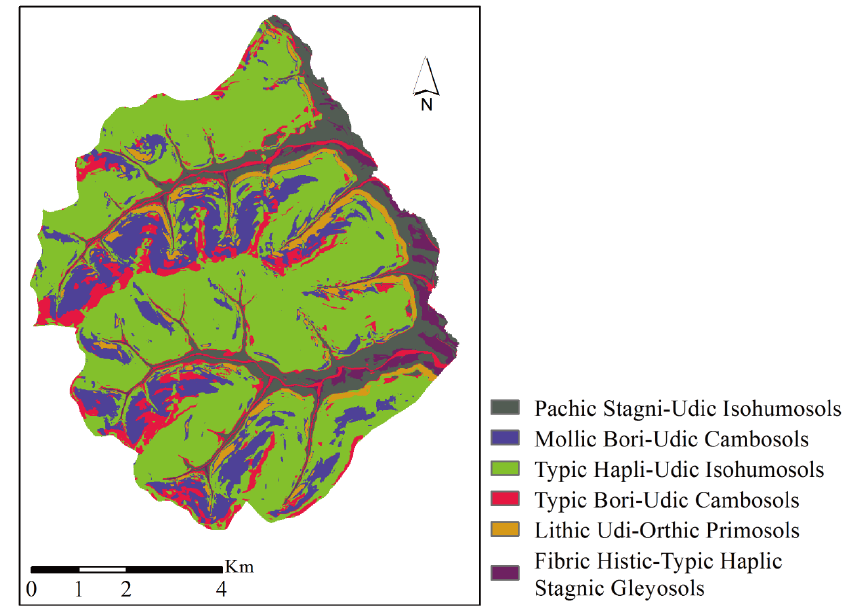
Figure 8. Soil maps generated from random forests with soil type similarities as features only.